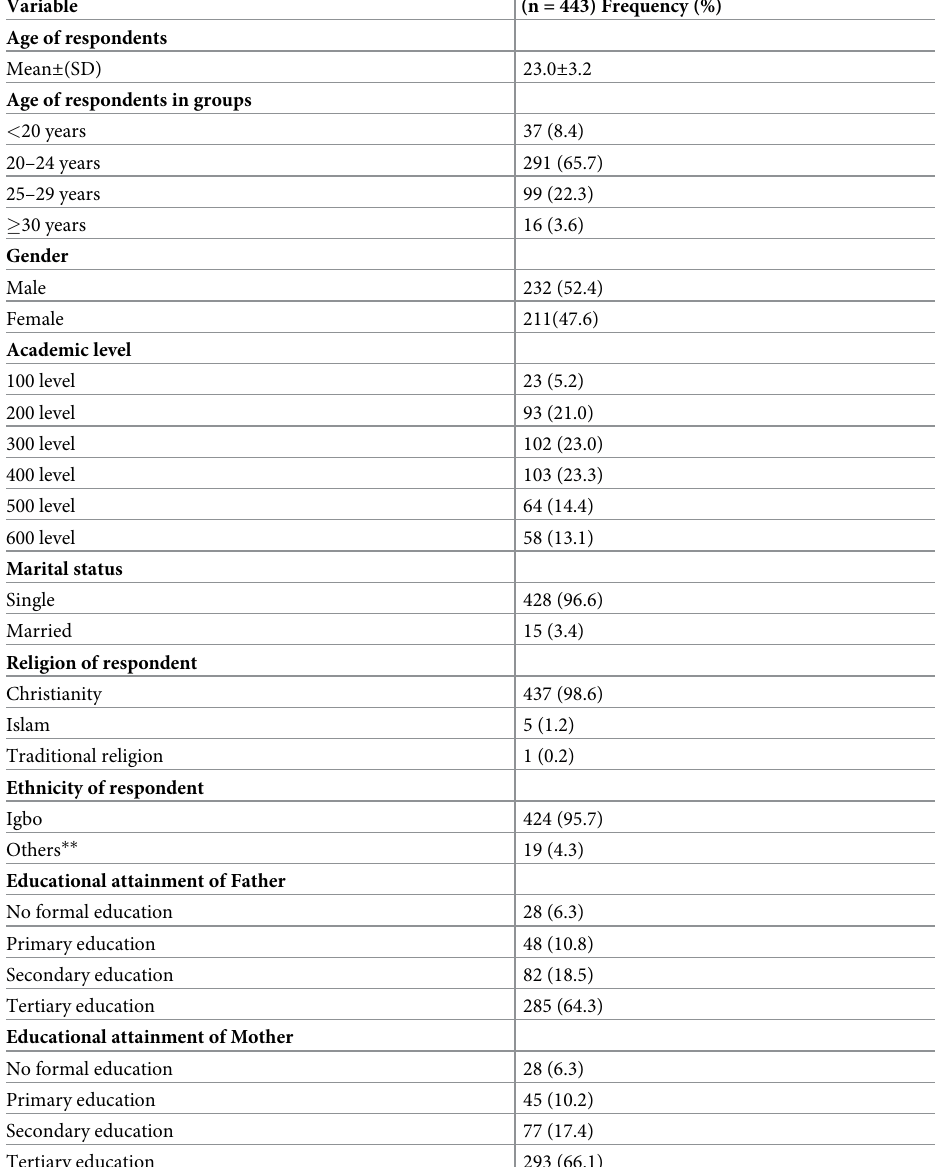
Table 1. Socio-demographic characteristics of